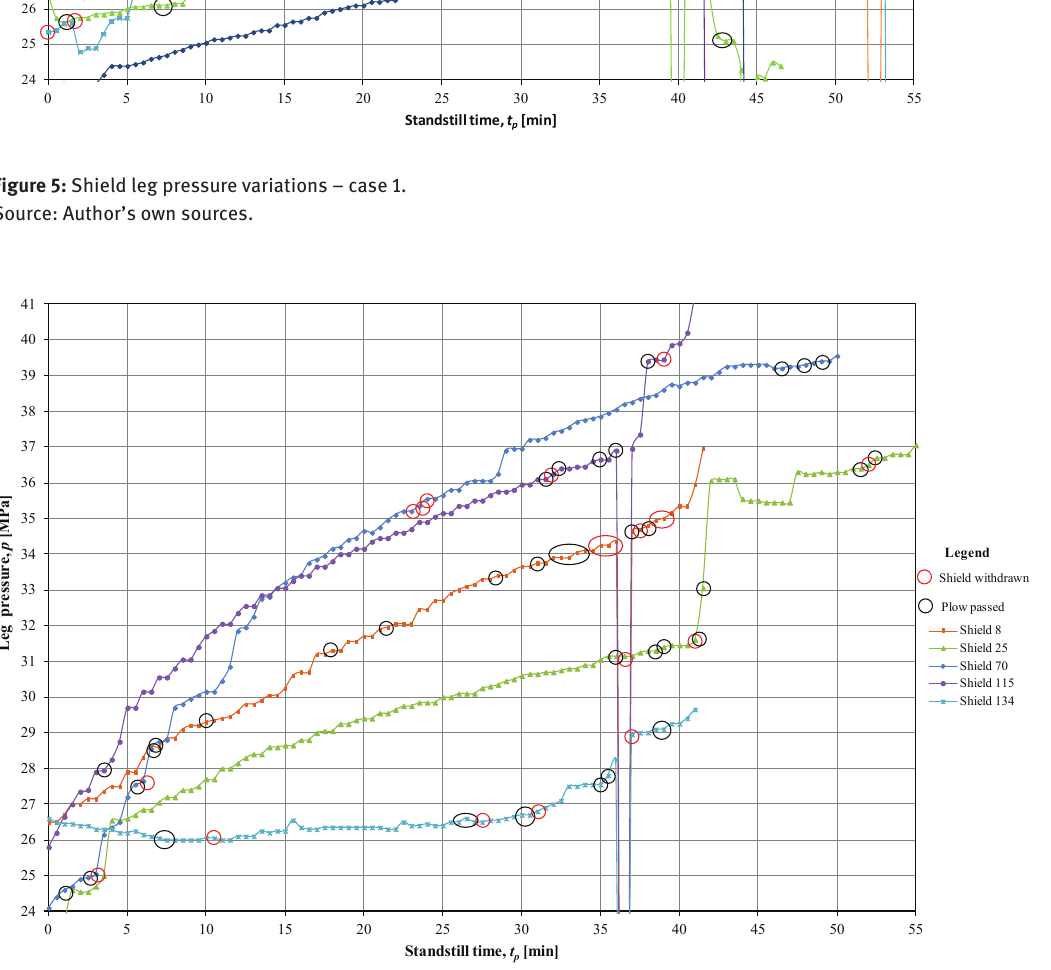
Figure 6: Shield leg pressure variations – case